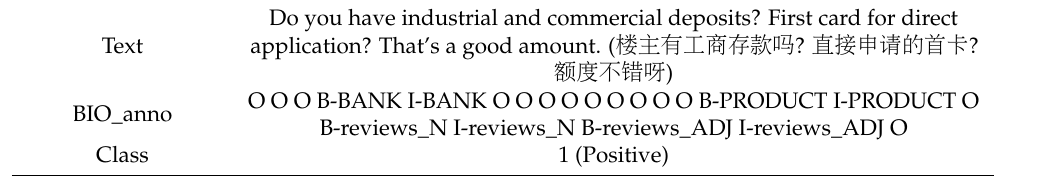
Table 1. Examples of training data.